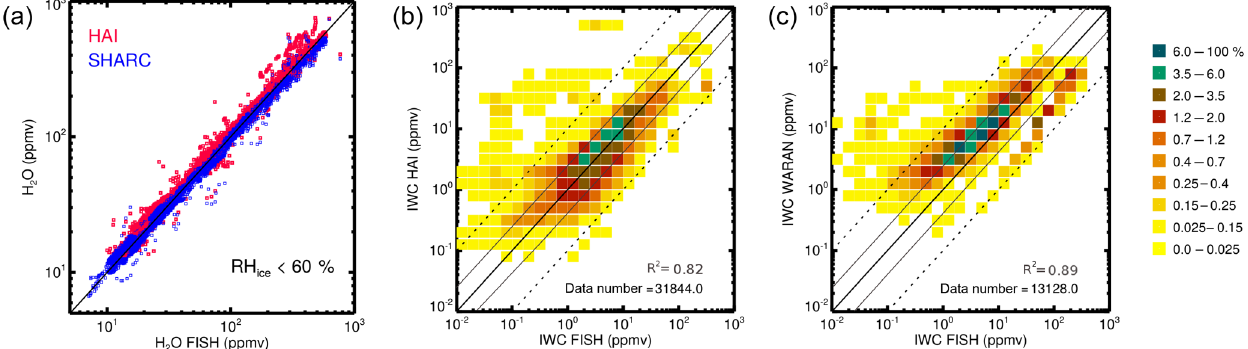
Figure 9. Comparison of H 2 O (a) and IWCs (b) from roof-mounted closed-path hygrometers FISH, HAI and WARAN (H 2 O tot ) and SHARC (H 2 O gas ) @HALO during ML-CIRRUS 2014 (color code: frequencies; solid black: 1:1 line; dashed/thin: ± factor 10/2.5 to 1:1 line). Linear regression coefficients for X = IWC FISH, Y = IWC HAI/WARAN are FISH/HAI (b) Y = 0 . 781 × X + 0 . 119, σ = 0 . 0032 and FISH/WARAN (c) Y = 0 . 761 × X + 0 . 472, σ = 0 . 0035; the correlation coefficients R 2 are shown in the respective panels. The FISH/HAI regression is calculated for the data range > 0.2ppmv (lower detection limit of HAI in the observed temperature range; see Fig. 3) and the FISH/WARAN regression for > 0.5ppmv (lower detection limit of WARAN; see Fig.